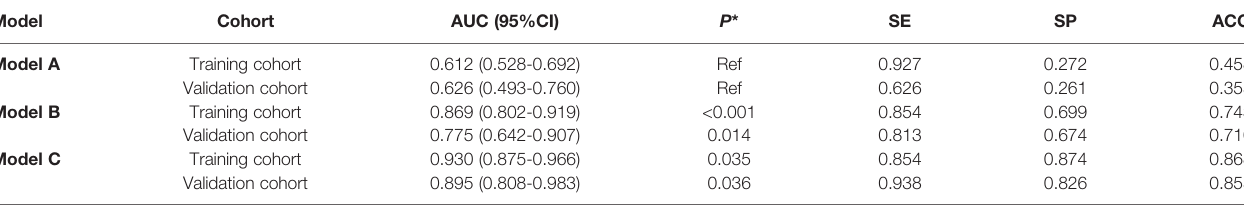
TABLE 3 | Performance of prediction models in the training cohort and validation cohort. Model